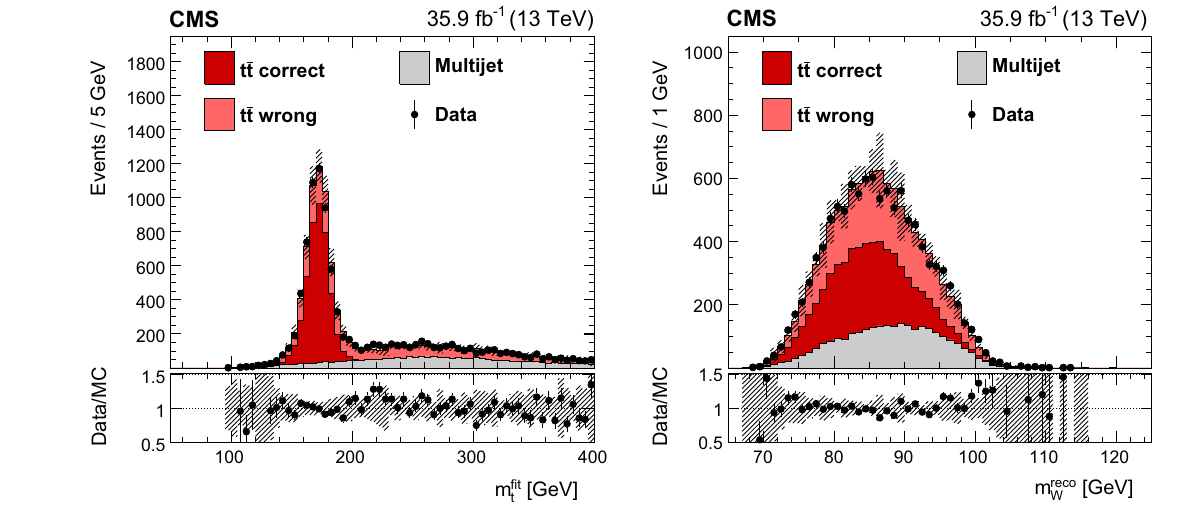
Fig. 2 The fitted top quark mass (left) and reconstructed W boson mass (right) distributions of data compared to simulated signal and the multijet background estimate. The shown reconstructed W boson mass is the average mass of the two W bosons in the event. For each event, the parton-jet assignment yielding the smallest χ 2 in the kinematic fit is used. The simulated signal events are classified as correct or wrong